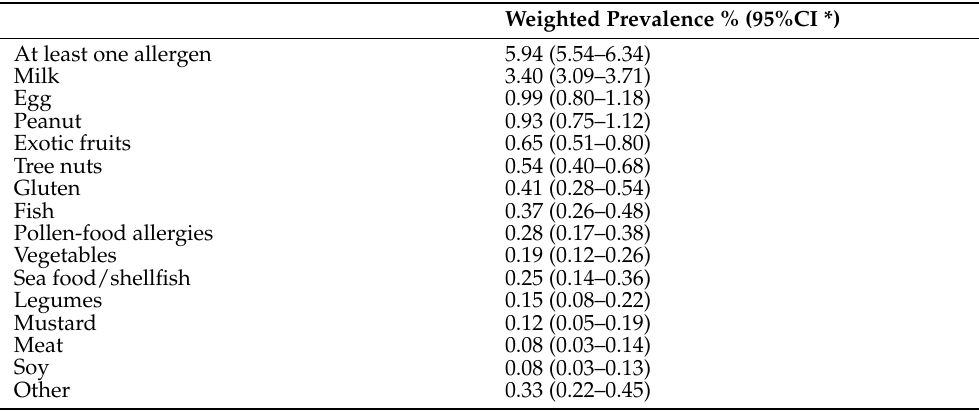
Table 3. Prevalence of food allergy up to 5.5 years of age in the ELFE cohort ( n =